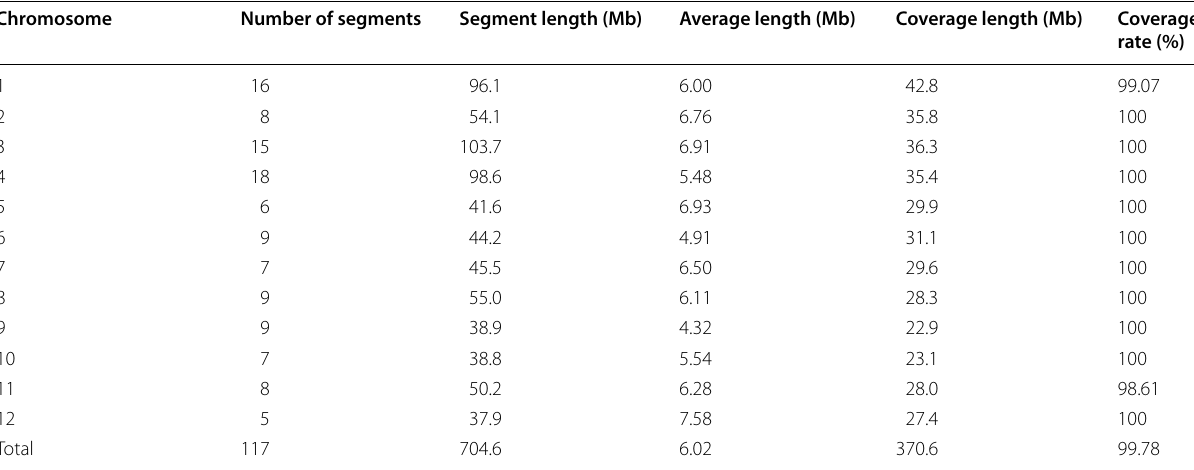
Table 1 Distribution of substituted segments on 12 chromosomes Chromosome Number of segments Segment length (Mb) Average length (Mb) Coverage length